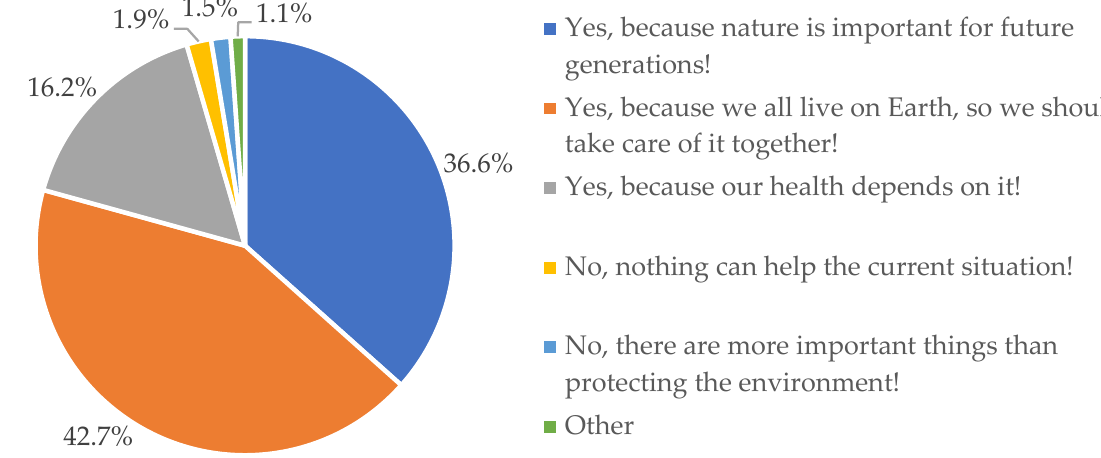
Figure 4. Distribution of students responding to the survey, according to whether they consider environmental protection important (%).